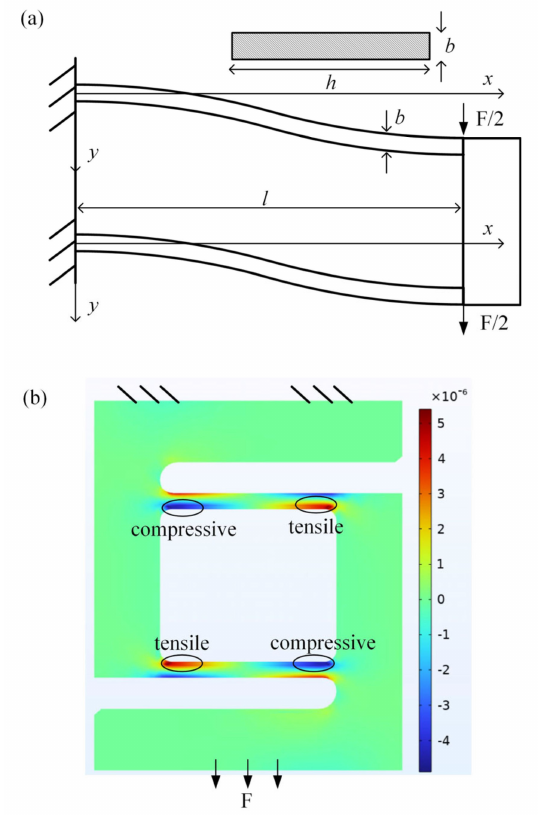
Figure 7. Bending and strain computation for the flexible beams of the force sensor: ( a ) schematic diagram of the bending beams; ( b ) Strain distribution obtained from the finite element